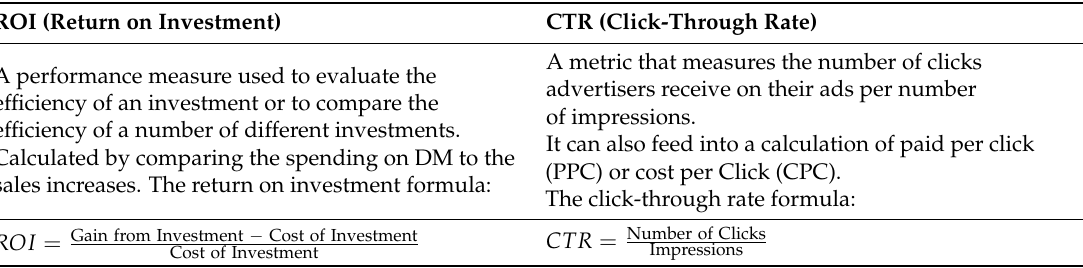
Table 4. Measures to calculate the ROI in